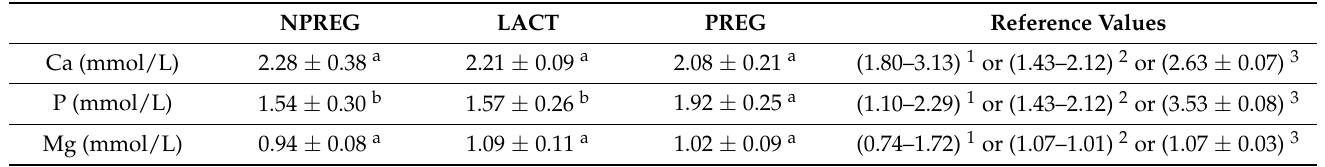
Table 6. Mean values (M ± SD) of Ca, P and Mg in non-pregnant non-lactating ( n = 14), non-pregnant lactating ( n = 8) and pregnant ( n = 38) she-camels. NPREG LACT